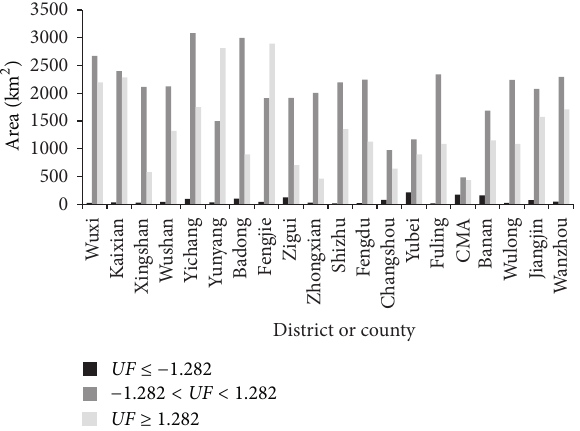
Figure 3: The area with significant trend based on classified 𝑈𝐹